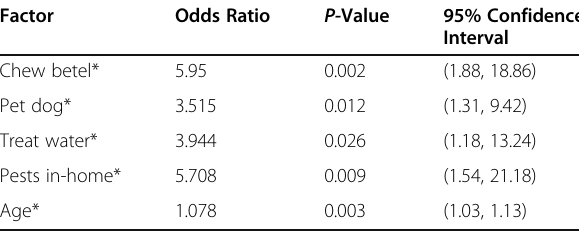
Table 3 Adjusted Odds Ratios for CKDu Using a Backward Stepwise